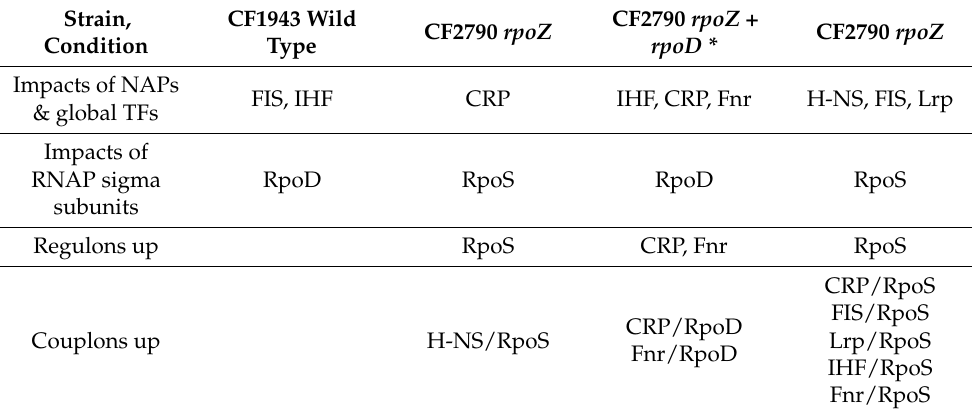
Table 2. Impacts of NAPs/global TFs and the RNAP sigma factors in the transcript profiles of growing cells (data from [39]). The first two columns compare the relative impacts in the profiles of wild-type and rpoZ mutants, the next two columns compare those in rpoZ mutant with and without rpoD